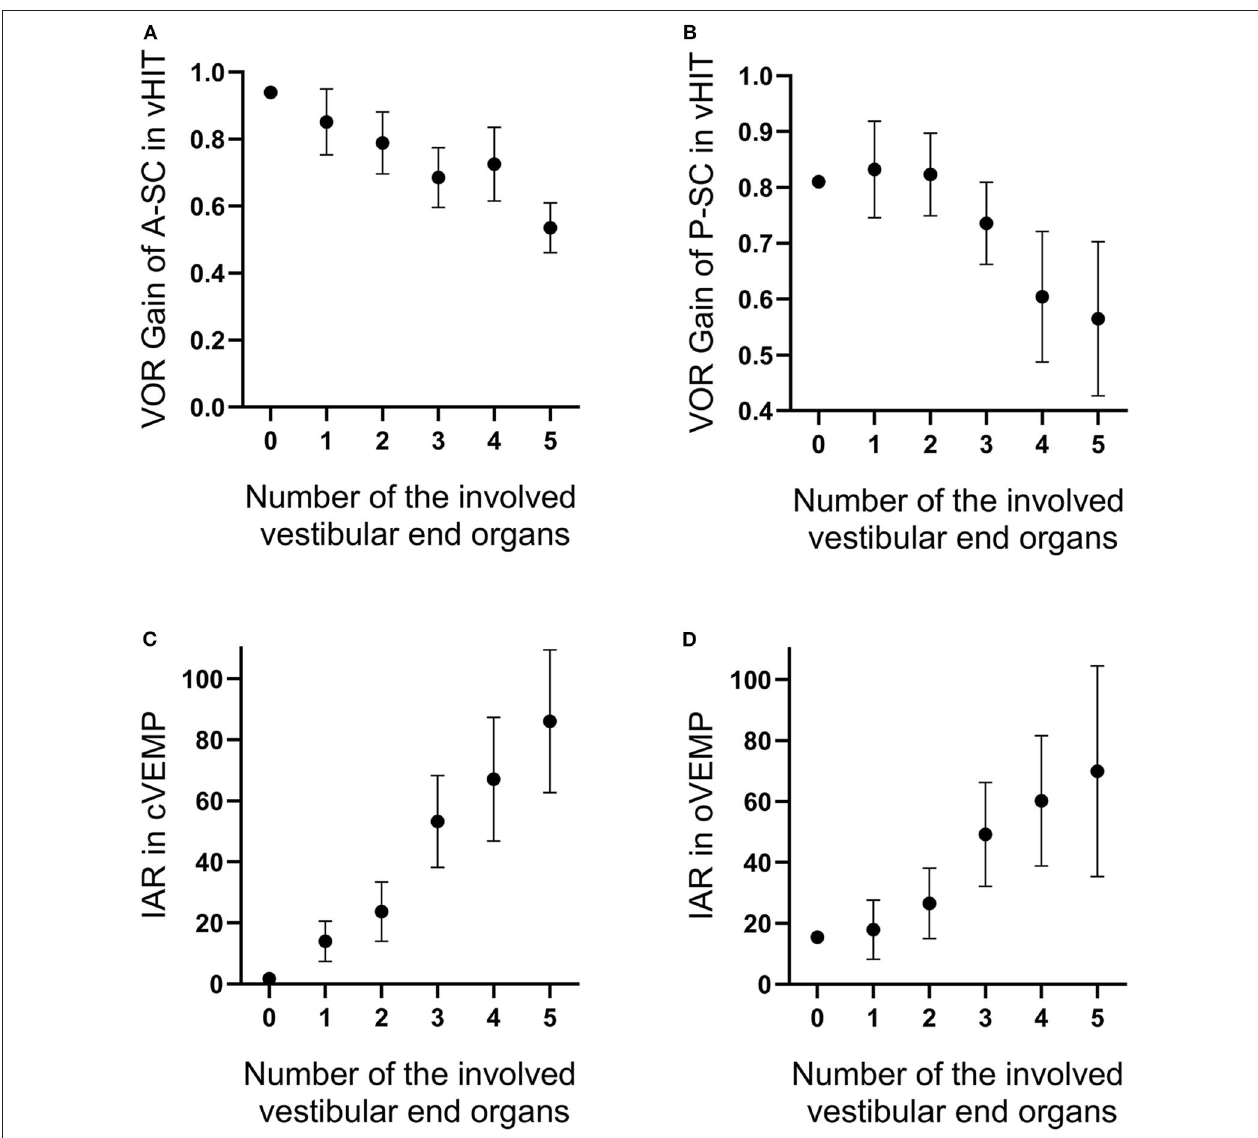
FIGURE 4 | The number of involved vestibular end organs is negatively correlated with the vestibulo-ocular reflex (VOR) gains of anterior (A) and posterior (B) semicircle canals tested in video head impulse test (vHIT) and is positively correlated with interaural asymmetry ratios in vestibular-evoked myogenic potentials (VEMPs) (C,D) . The range of error bars is the expression of 95% confidence